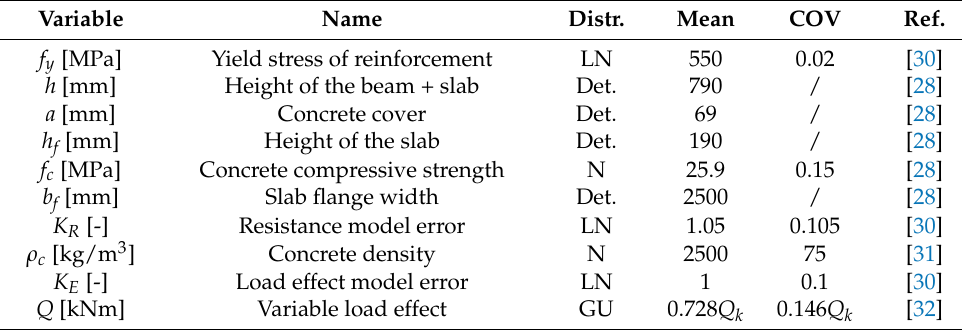
Table 1. Probabilistic distributions for the evaluation of the probability of